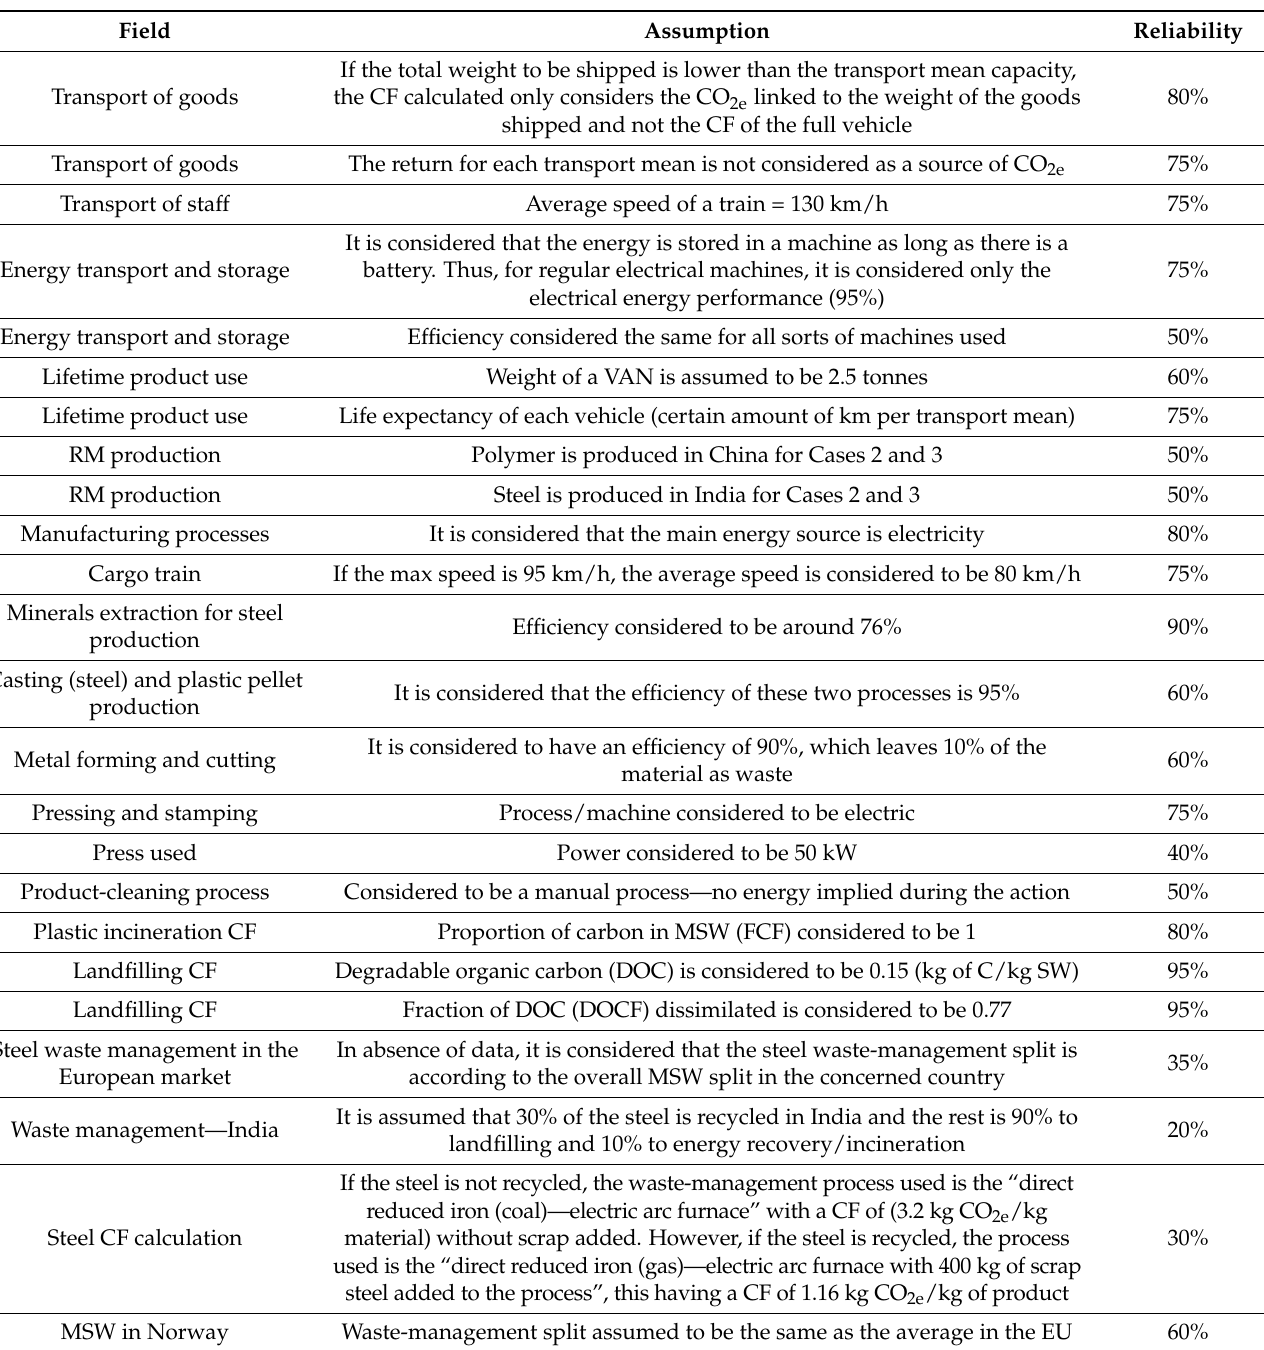
Table 40. Main assumptions used to complete the CF estimate linked to the expected reliability level presumed. Important to consider that the Reliability (%) is just a rough estimate based on the sort of missing data and/or the data sources